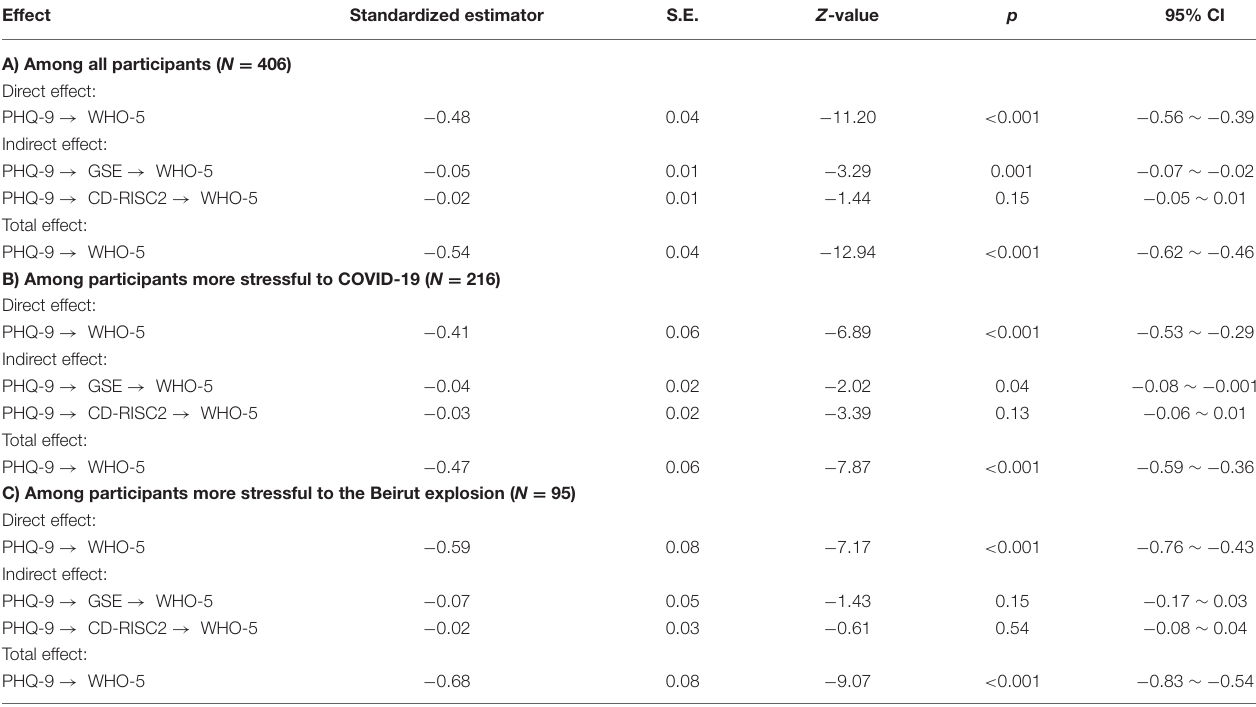
TABLE 4 | The mediation effect of self-efficacy on the relationship between depression and psychological well-being. Effect Standardized estimator S.E. Z -value p 95% CI